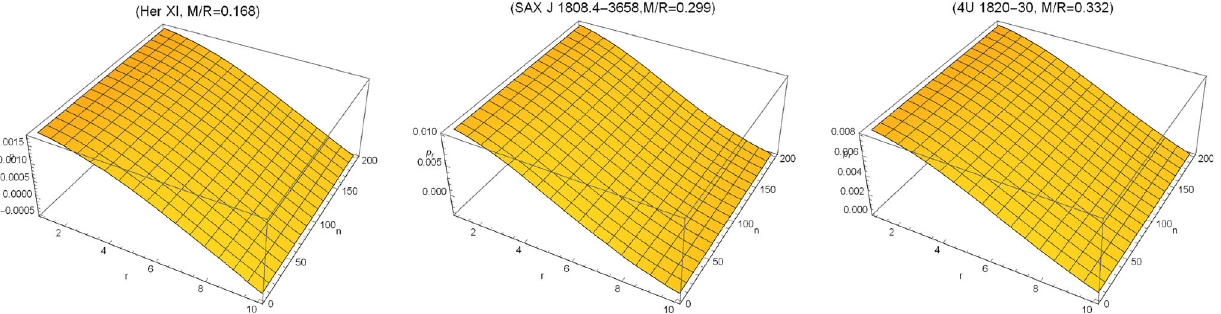
Fig. 4 Behavior of radial pressure p r with radial coordinate r (km) and model parameter